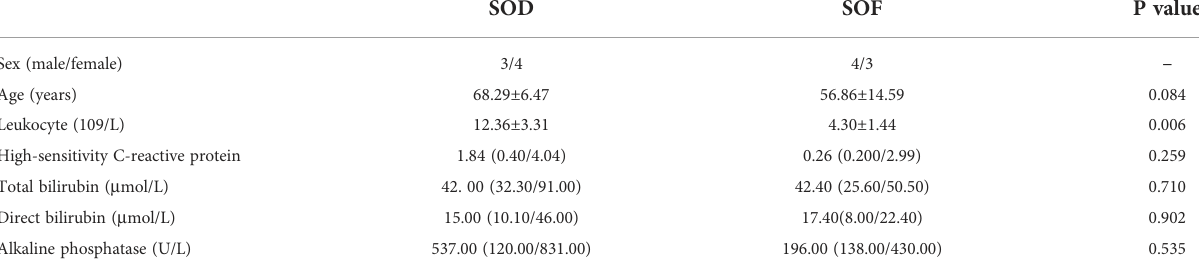
TABLE 2 General characteristic of the two groups of patients and the fi rst preoperative related laboratory indicators. SOD